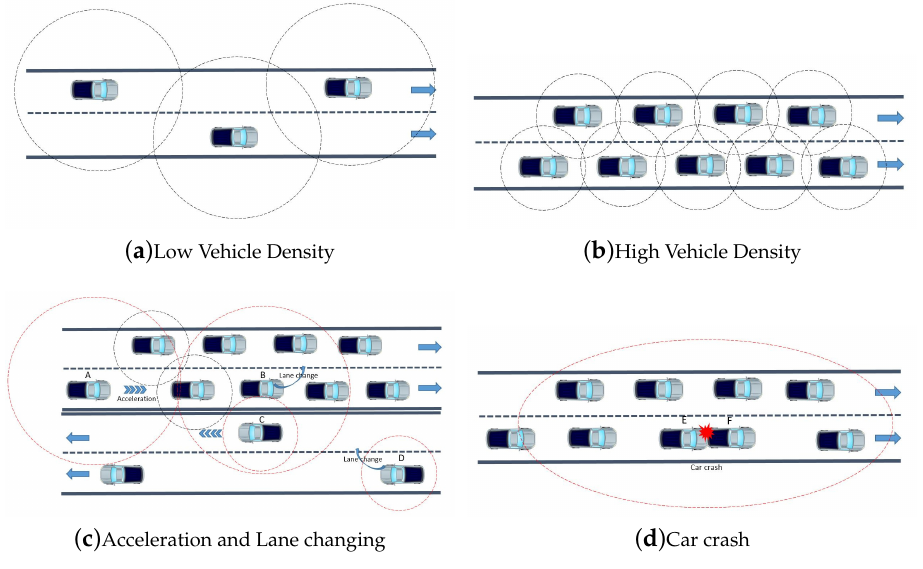
Figure 4. Driving